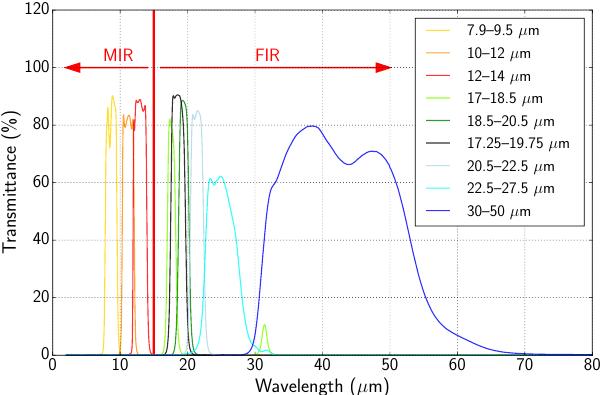
Figure 1. Spectral transmittances of the nine filters of the FIRR, whose band pass are indicated in the legend. Three filters cover the mid-infrared (MIR) and six are in the far-infrared (FIR).